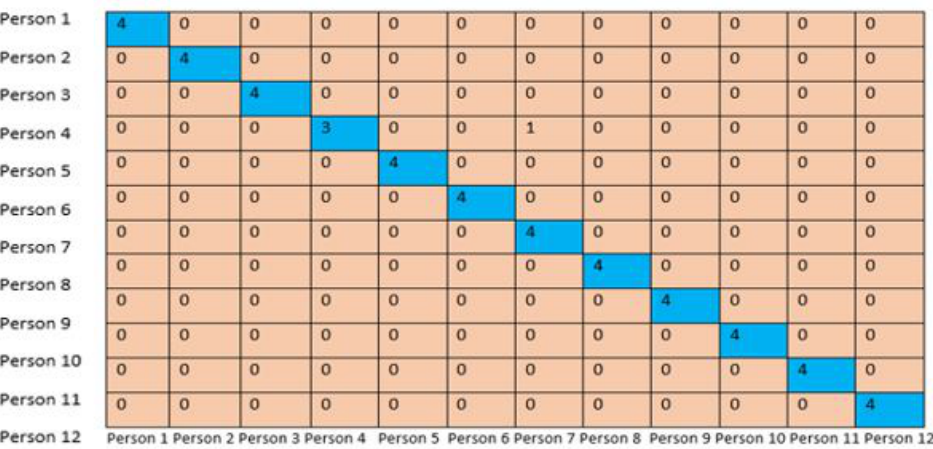
Figure 12. Confusion matrix for VMU image benchmark.